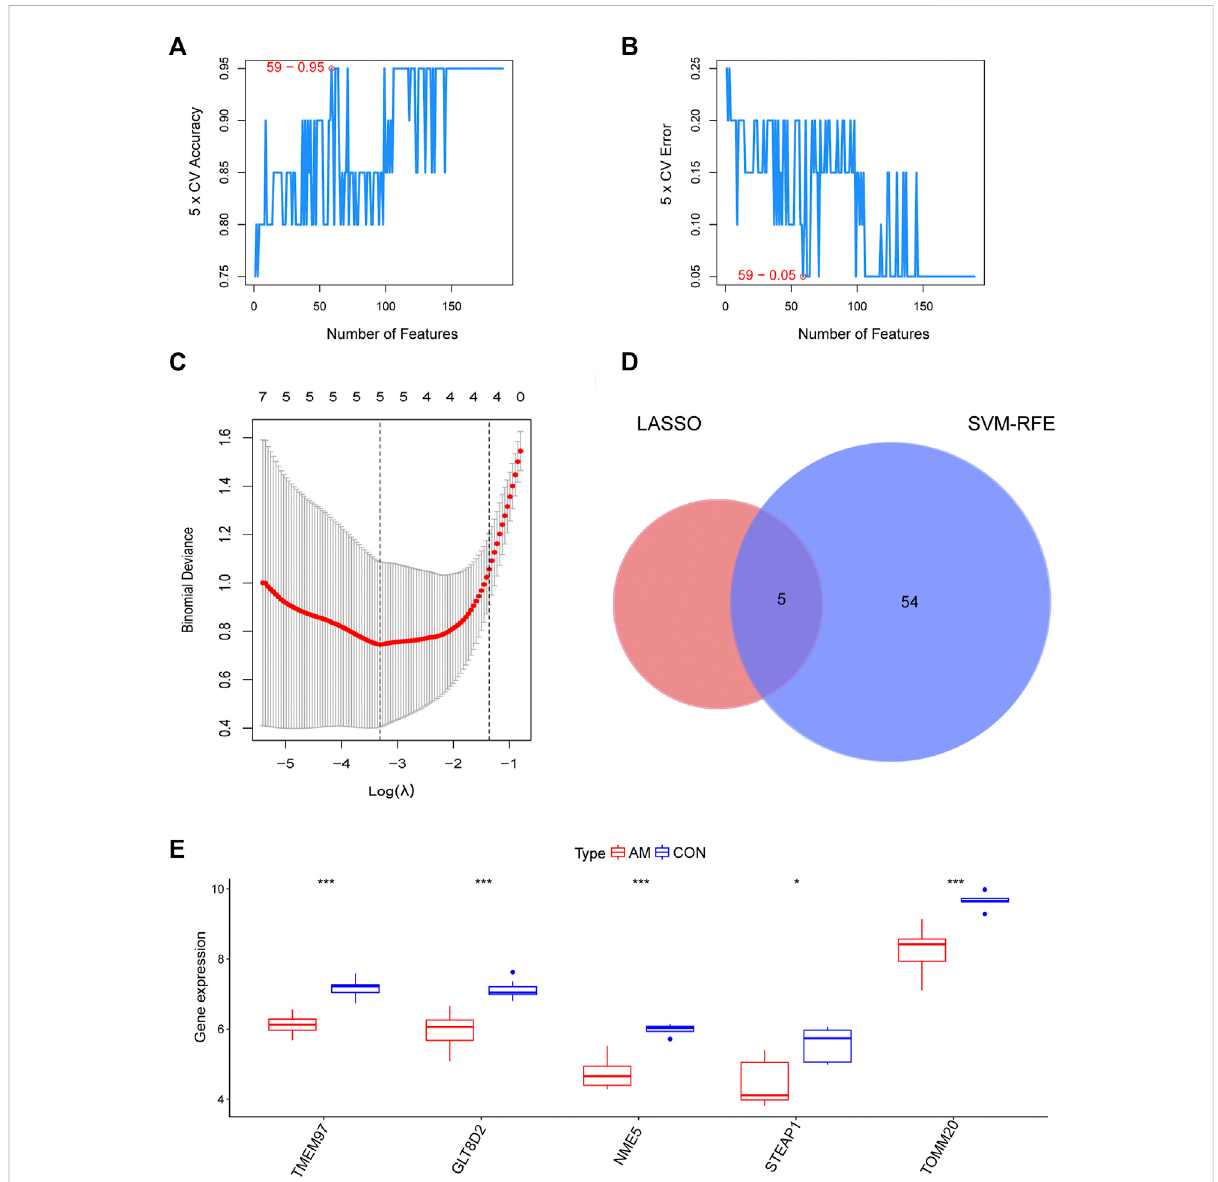
FIGURE 4 Identi fi cationofcandidatediagnosticbiomarkersbyacomprehensivestrategy. (A,B) Optimalgenesidenti fi edusingtheSVM-RFEalgorithm. (C) Signi fi cant prognostic variables screened using the LASSO regression. (D) Venn diagram of candidate diagnostic biomarkers screened using LASSO and SVM-RFE. (E) The expression of TMEM97, GLT8D2, NME5, STEAP1, and TOMM20 in microarray datasets (* p < 0.05, ** p < 0.01, *** p < 0.001, **** p < 0.0001).GLT8D2:glycosyltransferaseeightdomain-containingtwo;LASSO:theleastabsoluteshrinkageandselectionoperator;NDPK: nucleoside-diphosphate kinase; NME5: NME/NM23 family member fi ve expressed in nucleoside-diphosphate kinase; STEAP1: